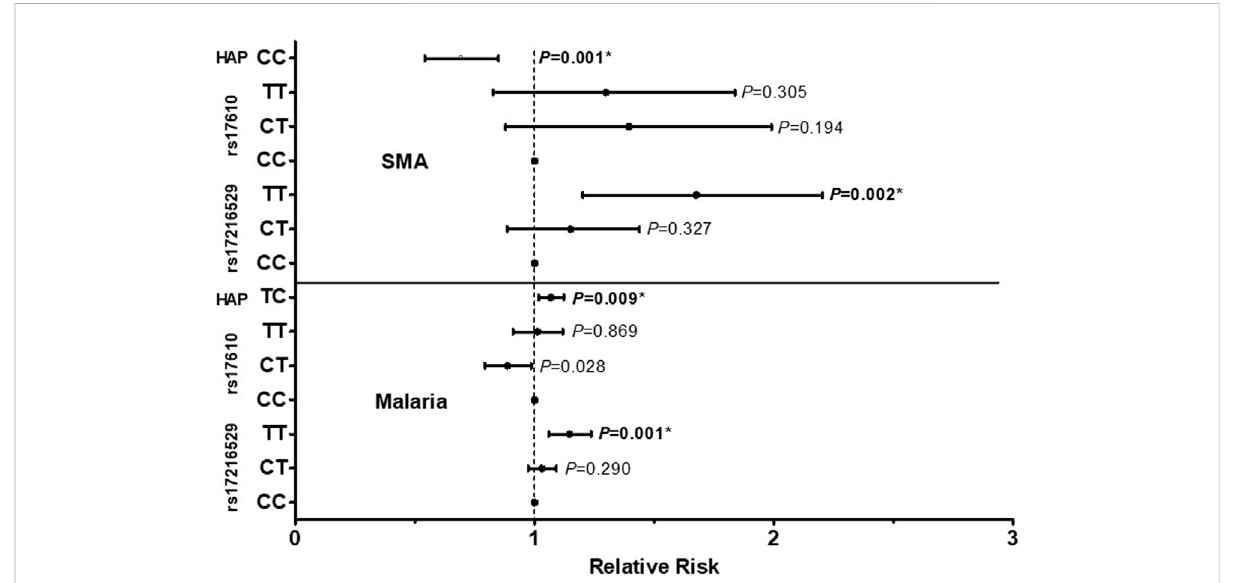
FIGURE 3 Atotalof1,546studyparticipantswereenrolledintothestudy.Theseweregrouped intothreecategoriesatenrollment:aparasitemic(n=288), uncomplicated malaria (UM, Hb ≥ 5.0 g/dl, n = 971) and SMA (Hb < 5.0 g/dl, n = 287). The in fl uence of C5 genotypes/haplotypes on the number of malaria and SMA episodes throughout the study period was determined by a Poisson rate regression (R glm function, family = Poisson), with the (logarithmof)ageatthepatientslastvisitsbeingtheoffsetvariable(rateregression).Aforward-backwardmodelselectionthatminimizetheAIC was used in the Poisson regression. The fi rst covariate inputs into the model were either C5 genotypes or haplotypes. Thereafter, additional covariates which included age at enrollment, sex, HIV, cohort, sickle cell status (sickle trait and sickle cell disease) glucose six phosphate de fi ciency (G6PD) and α thalassemia were entered into the model. The fi gure shows relative risk (midline dot) and 95% con fi dence intervals as determined by log-linear regression analyses, adjusting for age at enrollment, sex, HIV, cohort and sickle cell status (sickle trait and sickle cell disease). This cohort for followed quarterly for a period of 36 months *Signi fi cant after Bonferroni-Holm